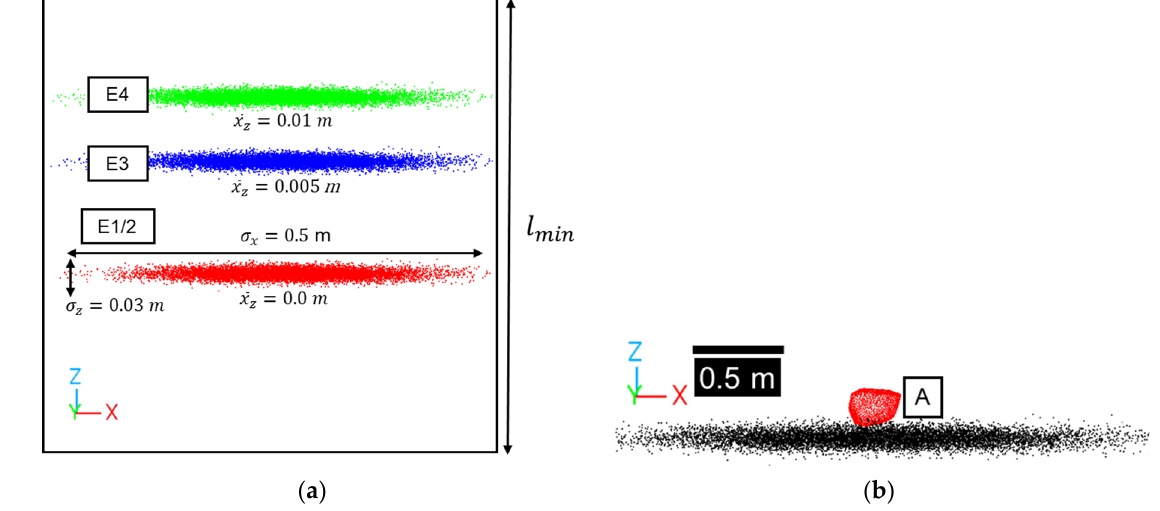
Figure 4. Overview of SDS1 E1-4 inside a schematic voxel ( a ) and SDS2 ( b